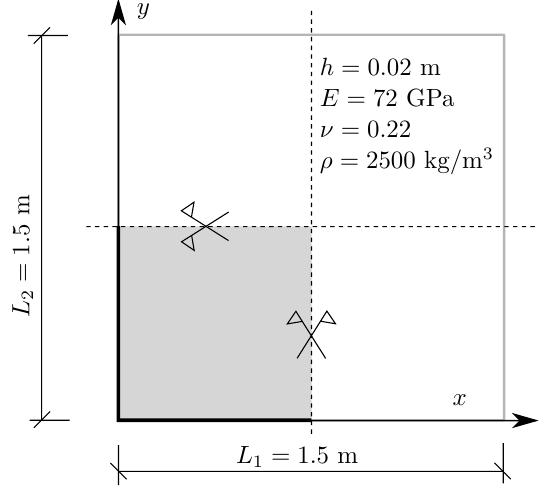
Figure 1. Setup of investigated